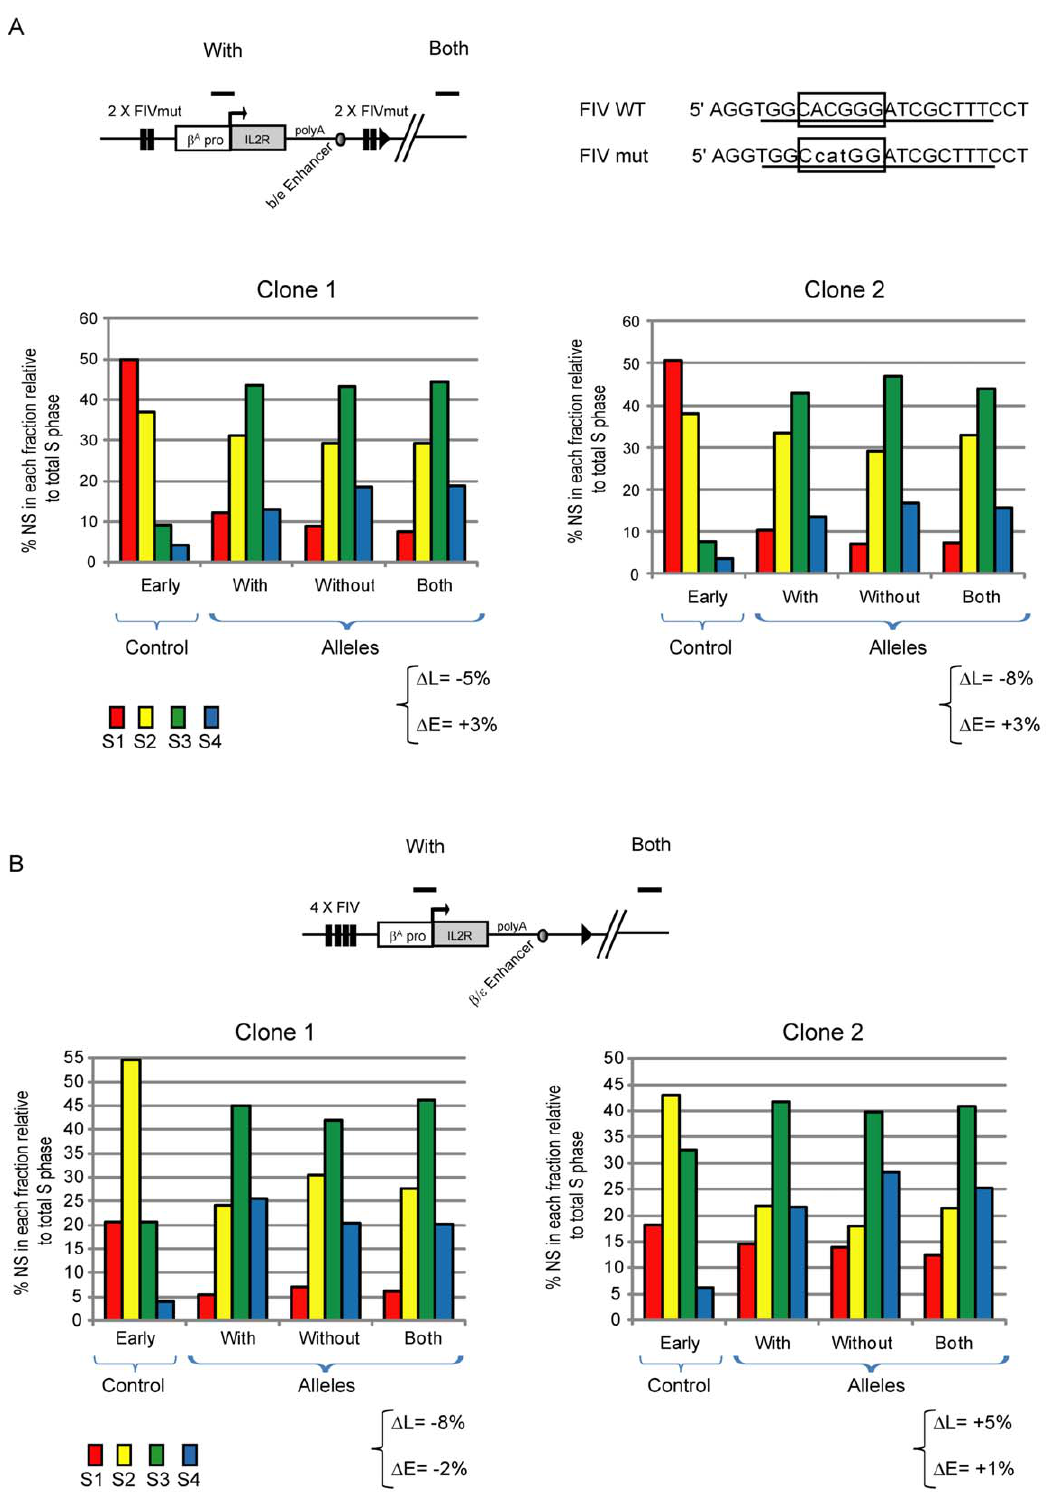
Figure 7. Mutation of USF elements abolishes replication timing control. Replication timing profiles of DT40 chromosomal alleles following targeted integration of insulator containing transgenes. (A) Analysis of two transgenic lines containing the IL-2R transgene flanked by two copies of FIV as described in Figure 6B, except that the FIV sites carry E-box mutations known to disrupt USF binding. The sequences of wild type FIV (FIV WT) and mutated FIV (FIV mut) are shown; bases footprinted by USF binding are underlined and the degenerate E-box motif is boxed. (B) Analysis of two transgenic lines containing the IL-2R transgene flanked on one side by four copies of FIV. The differences in late or early replication ( D L and D E) at the target site following transgene integration are shown.